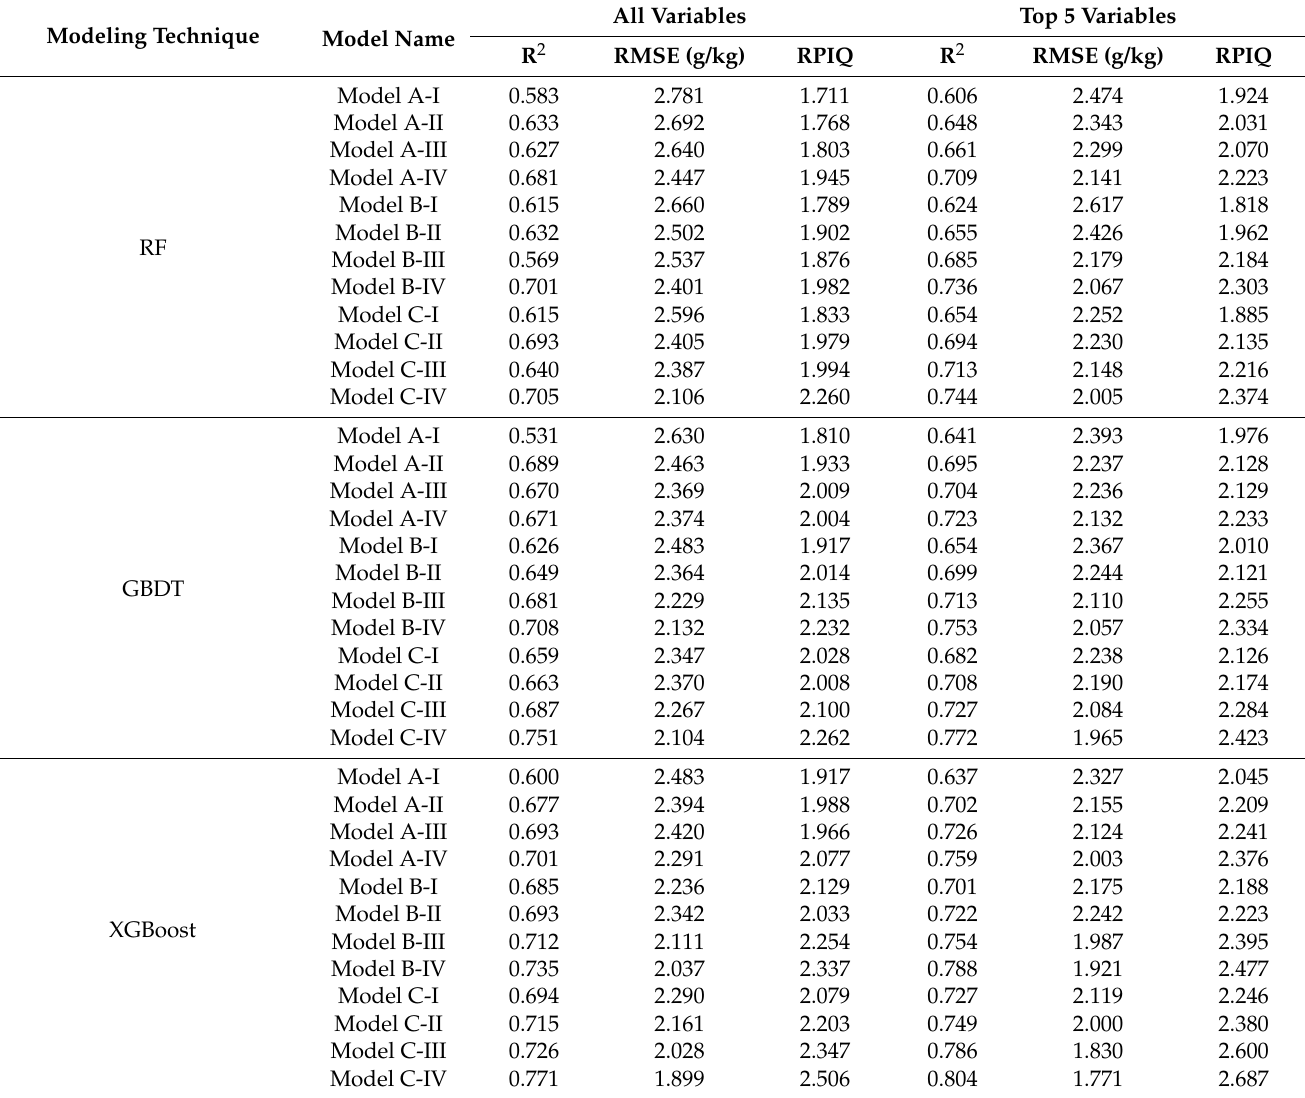
Table 7. Predictive performances of the